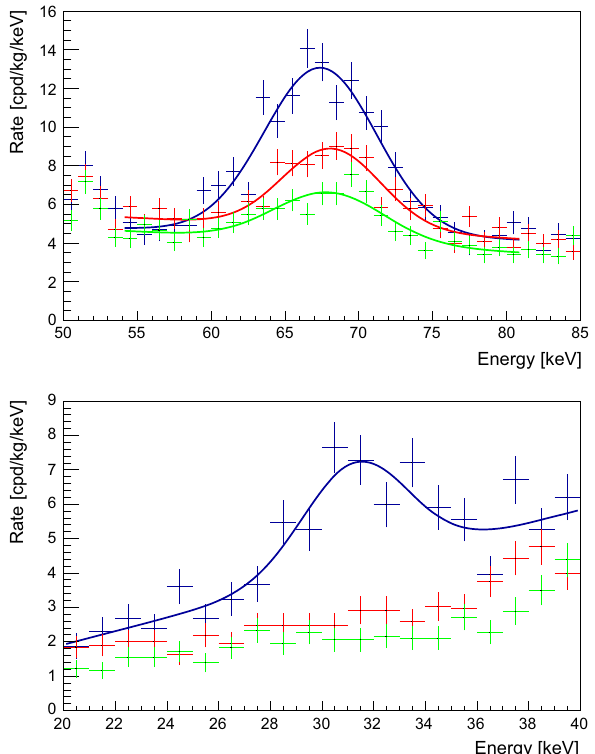
Fig. 6 Fit to the experimental spectra acquired at different time peri- ods: 29 days (blue), 78 days (red) and 104 days (green) after the arrival of the detector underground. The peak at 67.3 keV (top) is attributed to the decay of 125 I, while the peak at 31.8 keV (bottom) is attributed to the decay of 126 I and is visible only in the measurement at 29 days, given the short decay